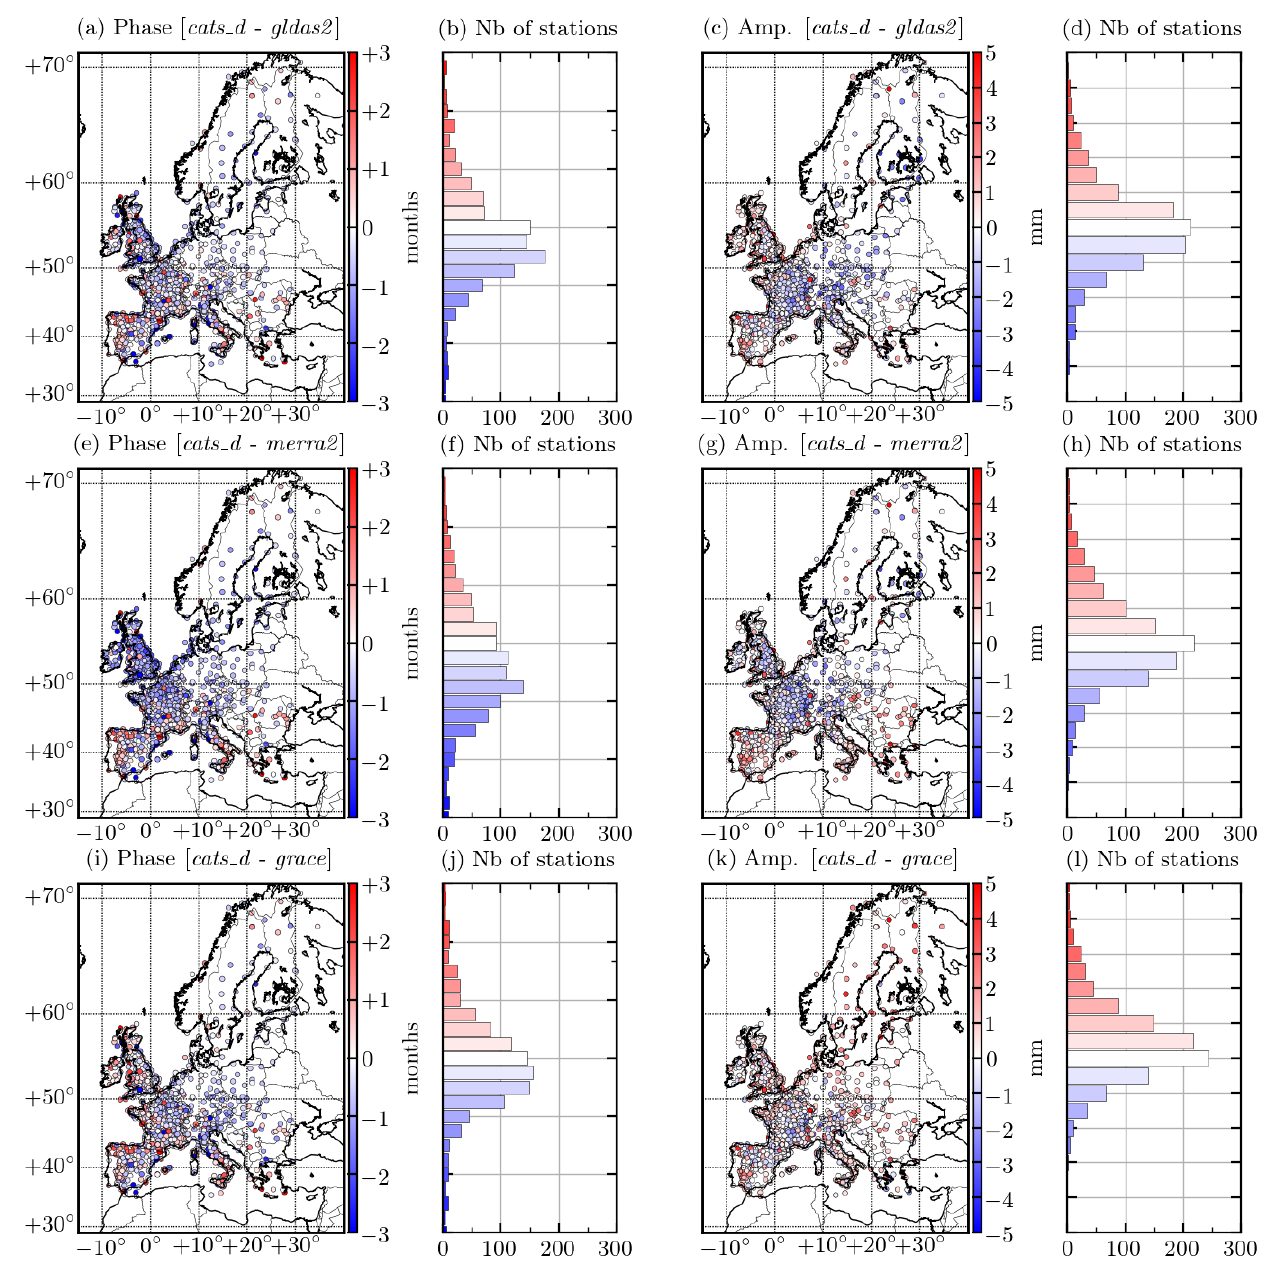
Figure 9. Differences in phase and amplitude of annual solar cycle and the associated histograms as described in Figure 8 between cats_d and GLDAS2.1 ( a – d ), MERRA2 ( e – h ), and GRACE ( i – l